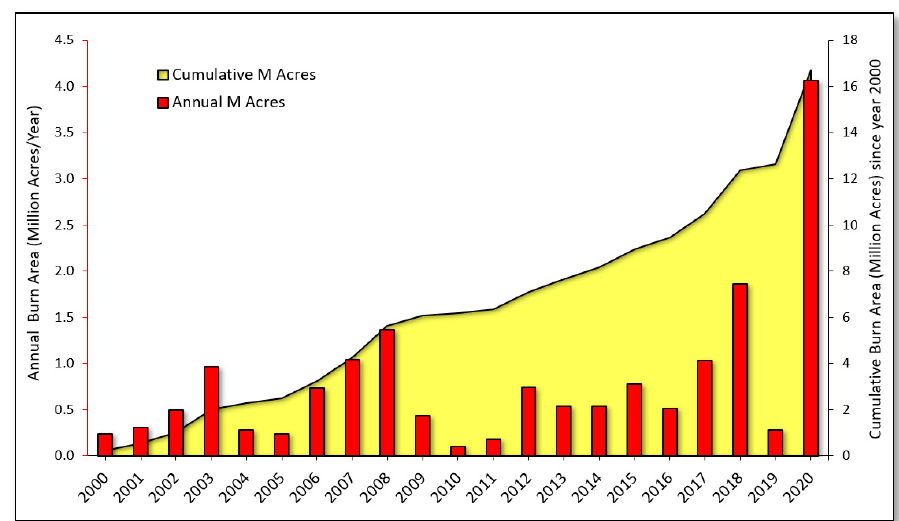
Figure 1. Cumulative and annual wildfire-burned area in California from 2000–2020.